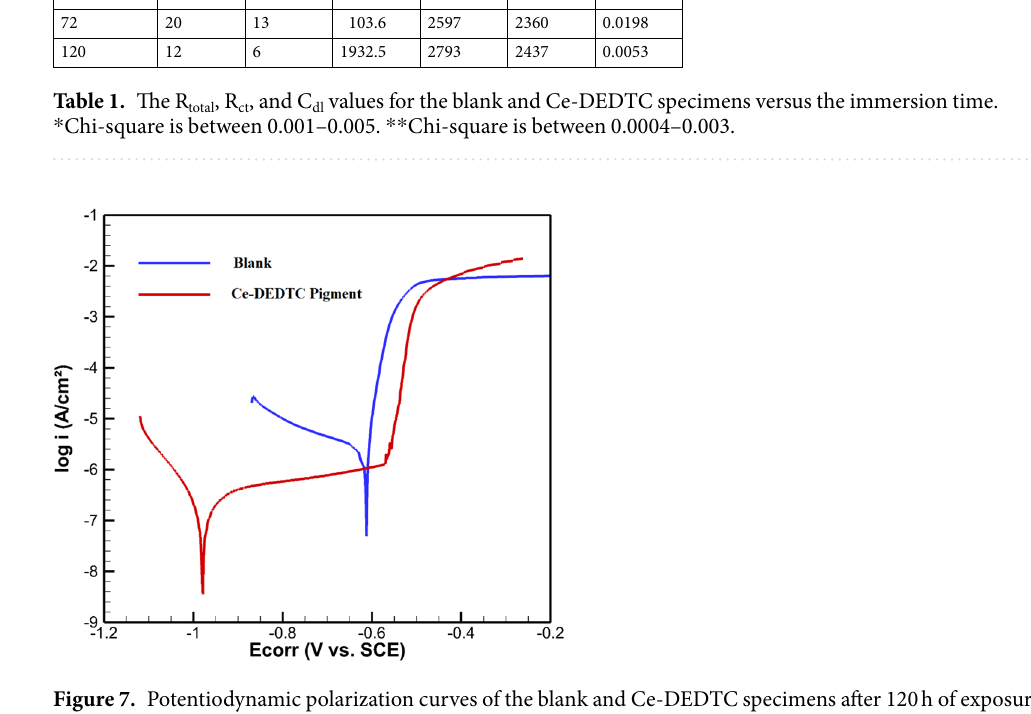
Figure 7. Potentiodynamic polarization curves of the blank and Ce-DEDTC specimens after 120 h of